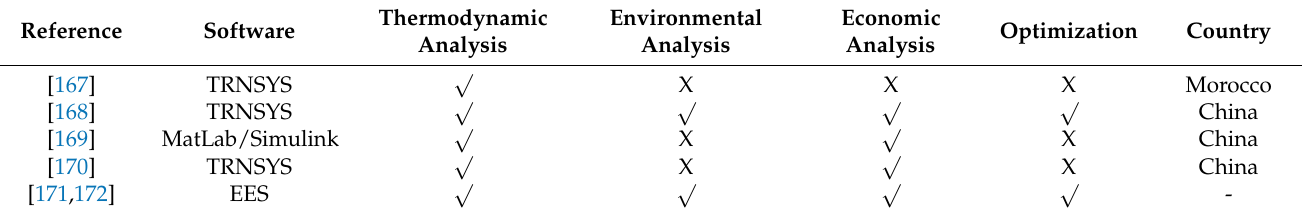
Table 5. Theoretical studies on hybrid renewable biogas